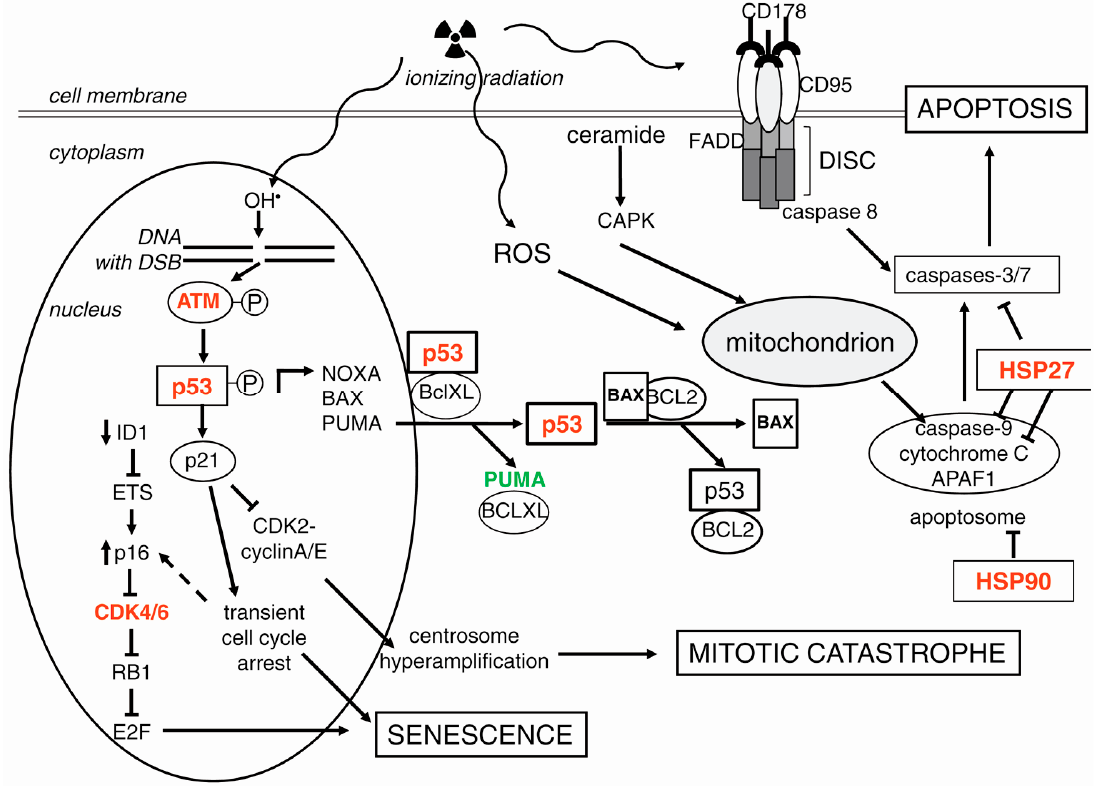
Figure 2. Cell death pathways after irradiation. Apoptosis is mostly induced by irradiation (symbolized by the sinuous arrows and the trefoil) in hematopoietic cells, or in cells of the mucosa in the gastro-intestinal tract, or in p53 wildtype tumor cells. DSB-dependent activation of p53 results in increased expression pro-apoptotic genes, inducing the intrinsic apoptotic pathway (see the text for details). Additionally, apoptosis might be induced by irradiation due to reactive oxygen species (ROS) production, or by activation of the second messenger ceramide, or the extrinsic apoptotic pathway. In contrast, the cell fate in most normal tissues is senescence induced by the p53/p21 and the p16/RB1 pathways, which result in cell-cycle arrest in the G1 phase and subsequent senescence (see the text for details). In p53-deficient cells, the blockage of CDK2-cyclinA/E by p21 is not functional; thus, centrosome hyper-amplification might occur, which is the prerequisite for mitotic catastrophe. This kind of cell death is caused by irradiation in most solid tumor entities. Arrows symbolize activation, the arrow with dotted line indicates a postulated effect; bar-headed lines symbolize inhibition. Targets for radiosensitization are in red, for radioprotection in green. See text for details.